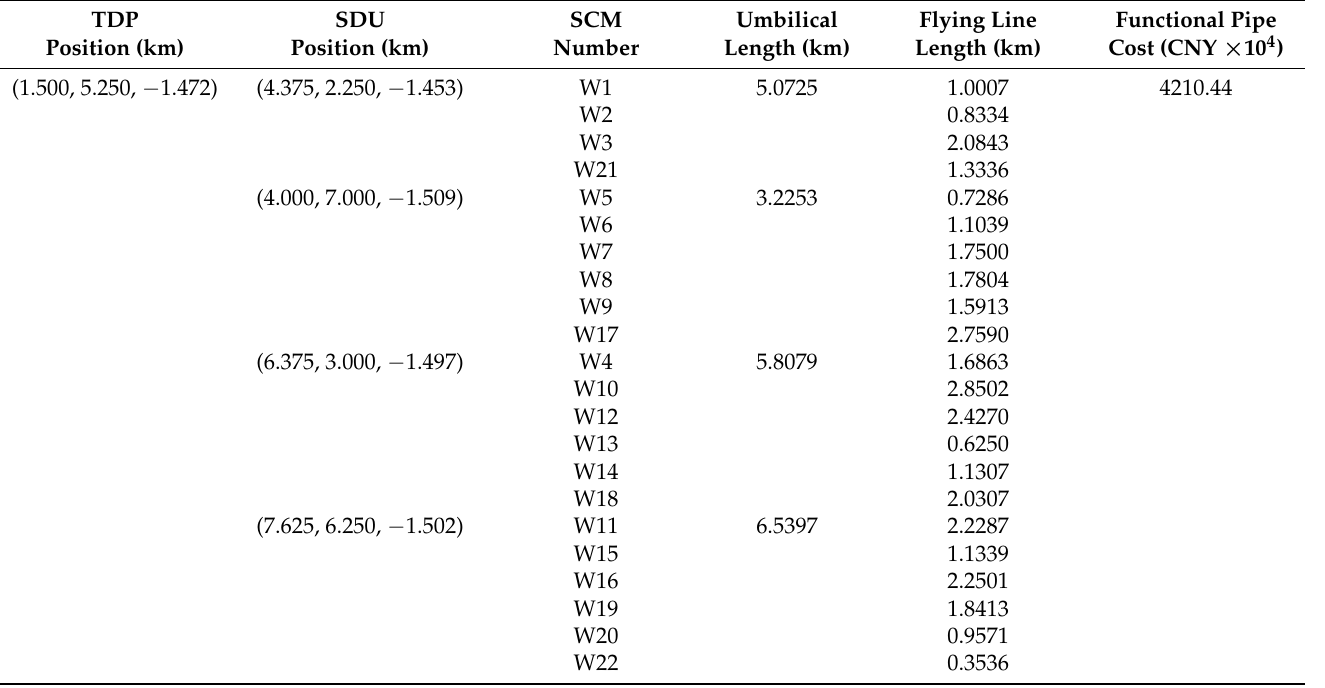
Figure 7. Top view of the optimal layout for the two layout structures. Table 5. The specific information of the optimal layout for MS layout